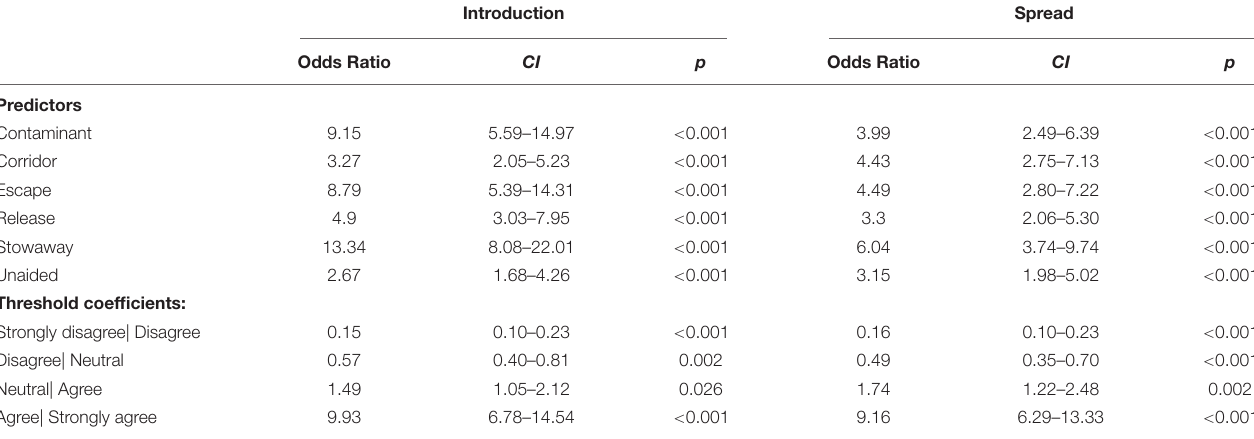
TABLE 3 | Proportional odds models, analyzing which pathway will significantly increase alien species (A) introductions and (B) spread to/on islands in the 21st